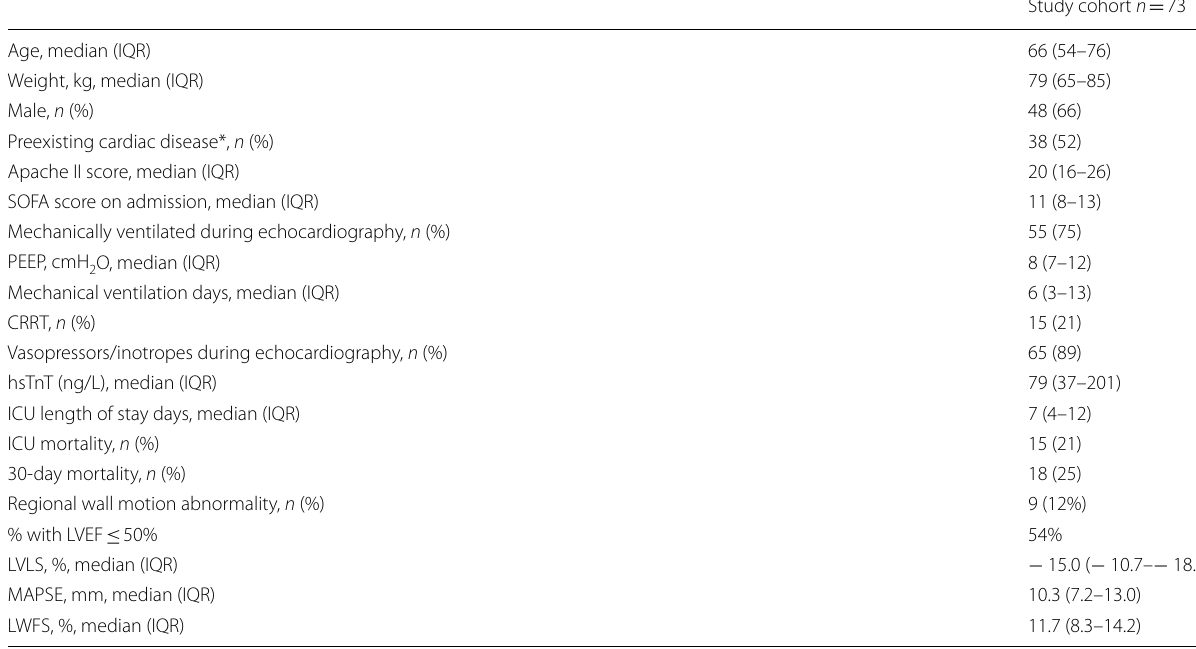
Table 1 Baseline patient characteristics on Day 1 of admission